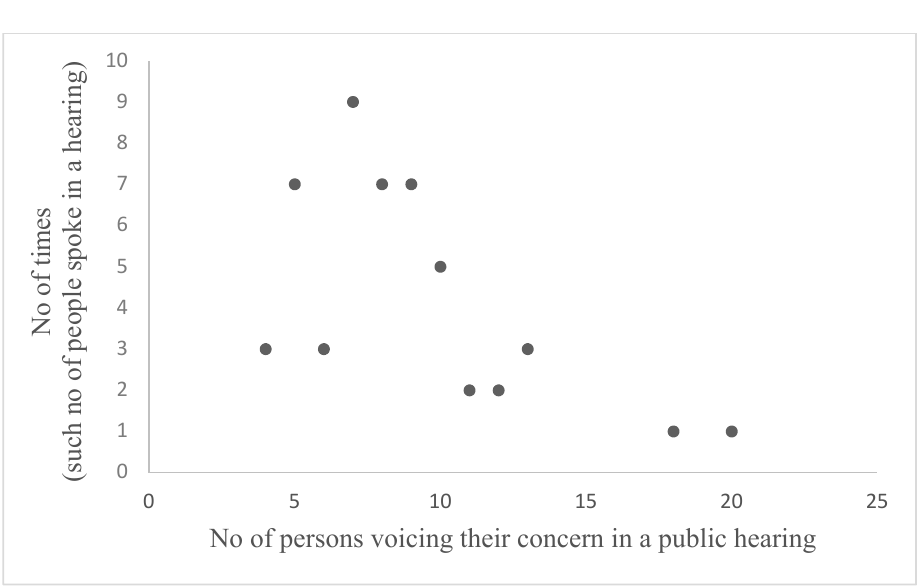
Figure 1. Number of persons speaking up in the 50 public hearings corresponding to 50 different proposed projects. relatedCER Jobs Pollution sourceRehabilitation Figure 2. Spread of questions/comments from people on different topics in the 50 public hearings. Corporate Environment Responsibility (CER) is need-based activities for the local people which the project proponent is required to do around the project area.